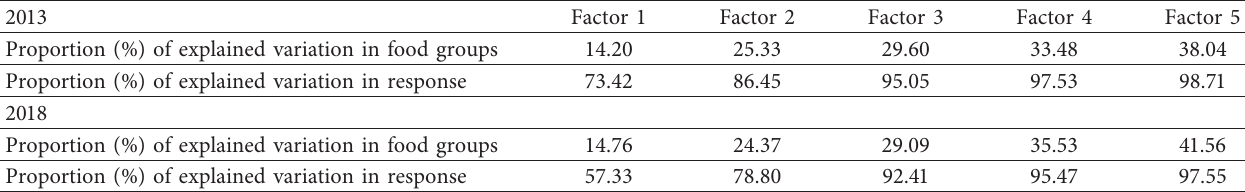
Table 3: Explained variations in response variables (total salt consumption) and food